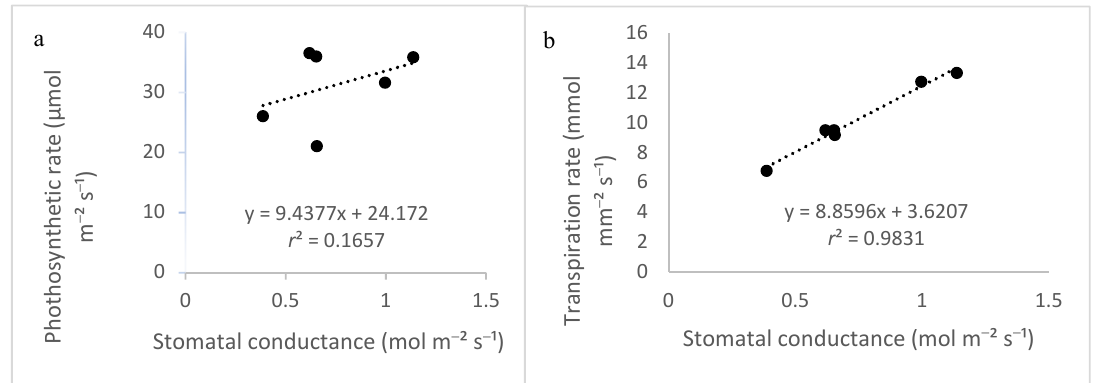
Figure 3. Correlations between the photosynthetic rate ( a ) and transpiration ( b ) against stomatal conductance at the maturing stage.